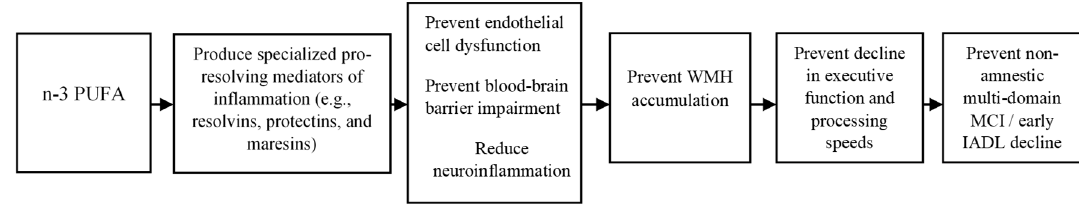
Figure 1. Hypothetical model for n-3 PUFA effects on age-related cognitive decline. Administration of n-3 PUFA makes them available for incorporation into cellular membranes and subsequent release by intracellular phospholipases that convert them into a variety of lipid bioactives. Unesterified circulating n-3 PUFA can arrive at sites of inflammation and undergo conversion into specialized pro-resolving lipid mediators, including the E-series resolvins derived from EPA via p450 metabolism, or aspirin acetylated cyclooxygenase and the D series resolvins, protectins, and maresins, derived from DHA via lipoxygenase or aspirin acetylated COX-2 [49]. Administration of n-3 PUFA is associated with down-regulation of cell adhesion molecules [48] that may govern blood–brain barrier permeability in older adults [31]. These cell adhesion molecules may play a role in cerebral small vessel disease as reflected by the accumulation magnetic resonance imaging derived white matter hyperintensities. Executive function and speed of processing are domains of cognition impacted by the accumulation of WMH, in contrast to episodic memory recall more influenced by deposits of Alzheimer pathology.